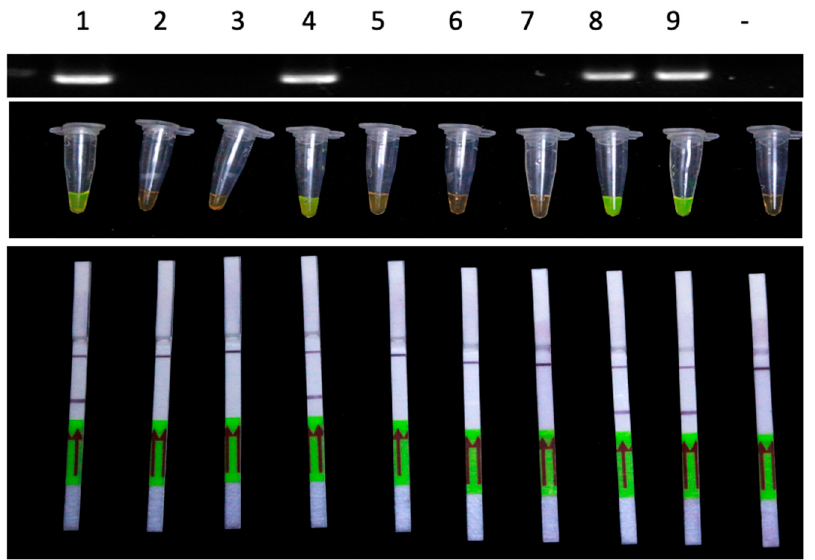
Figure 5. LAMP-LFD assay detection of ChTBV1 in Chinaberry tree field samples collected from Zhejiang Province. Top Panel: RT-PCR products separated by agarose gel electrophoresis. Middle Panel: LAMP products visualized with SYBR Green I dye; Bottom Panel: LAMP products visualized in LFD strips. Lanes 1–9: Chinaberry tree leaves from field samples; Lane -: negative template control (sterile ddH 2 O).